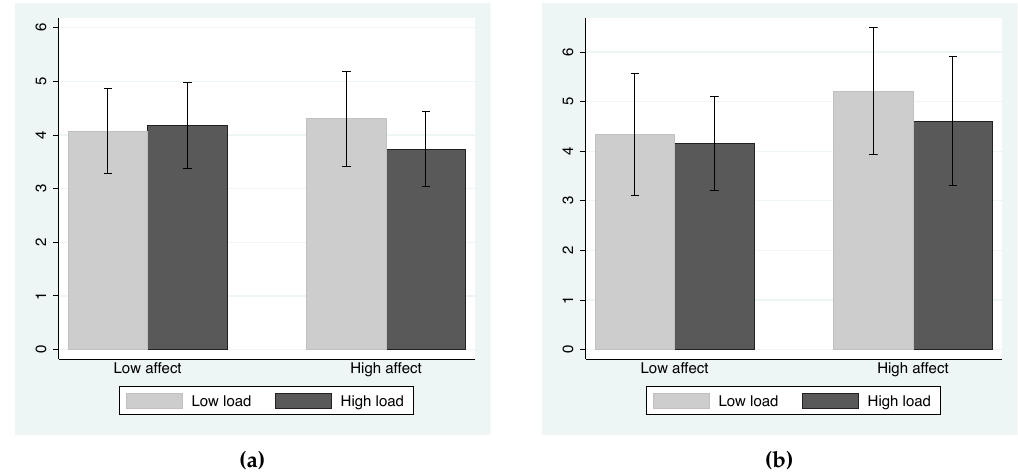
Figure 3. Mean donations by treatment with 95% confidence intervals. ( a ) Mean donations by men and women; ( b ) Mean donations by women